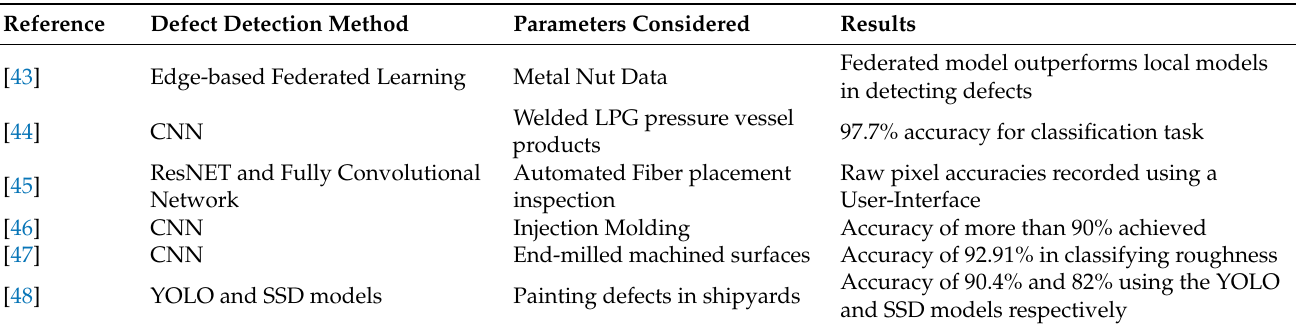
Table 2. Defect detection methods in